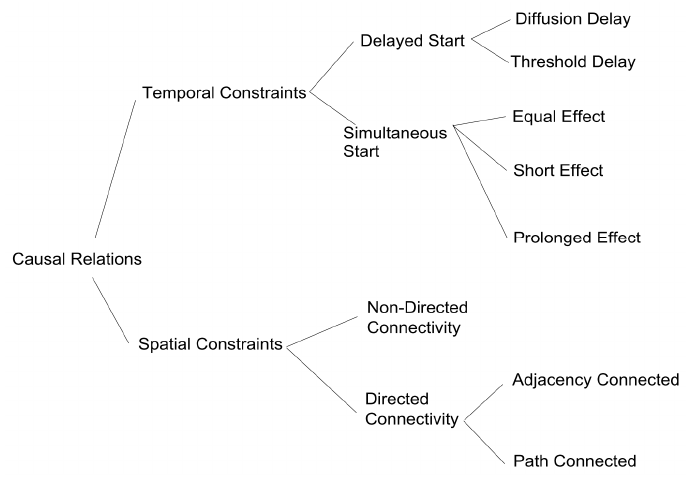
Figure 17. Classification of causal relations [6] .